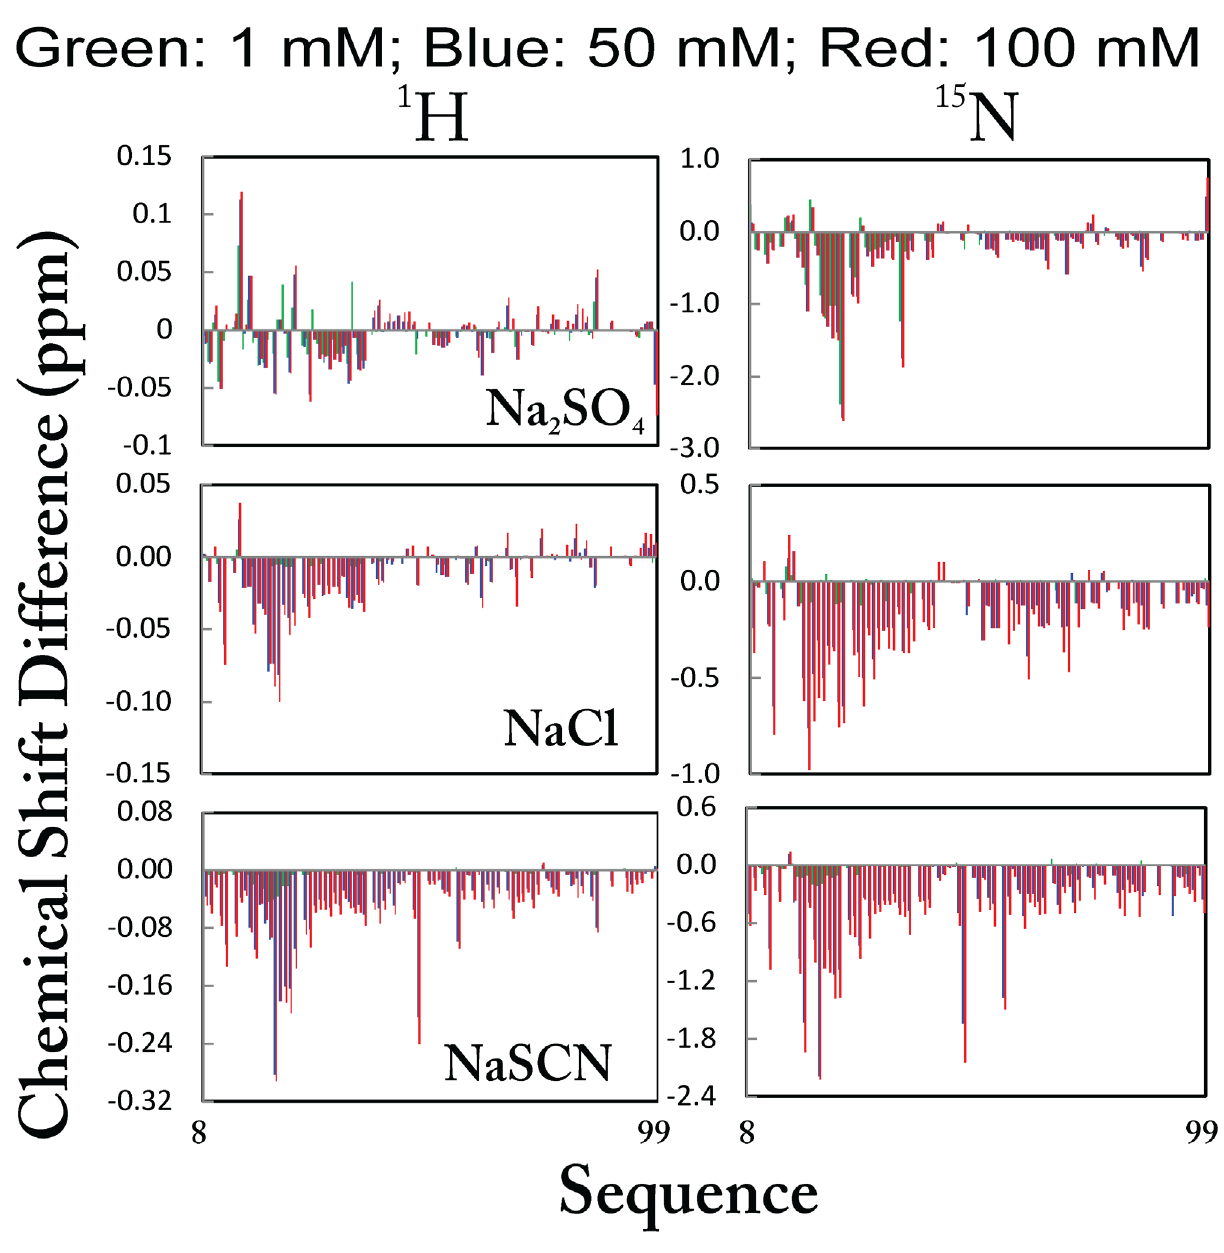
Figure 17. Specific anion-binding as revealed by NMR. Chemical shift difference (CSD) of the amide proton ( 1 H) and nitrogen ( 15 N) for residues of the entire ephrin-B2 cytoplasmic domain plus His-tag induced by the addition of Na